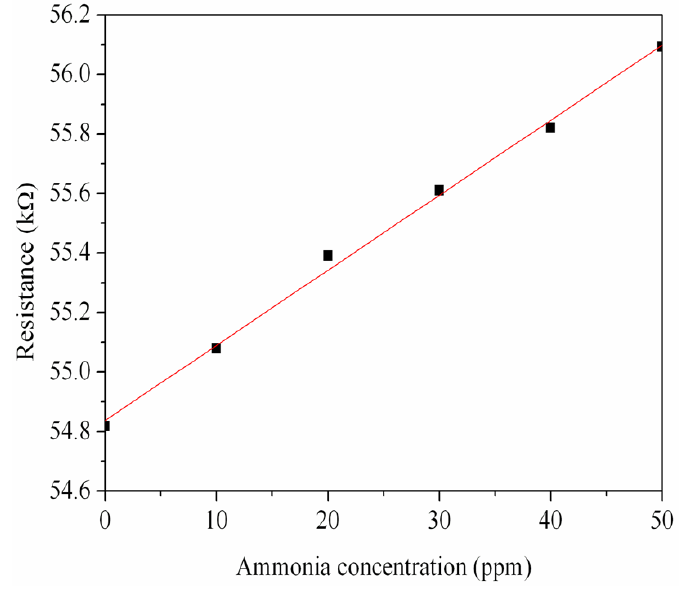
Figure 8. Measured results of the resistance for the ammonia